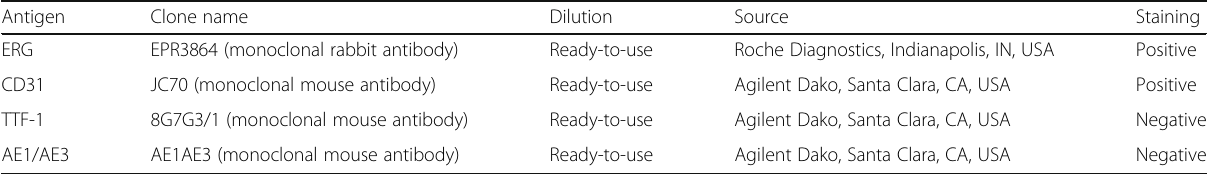
Table 1 Immunohistochemical